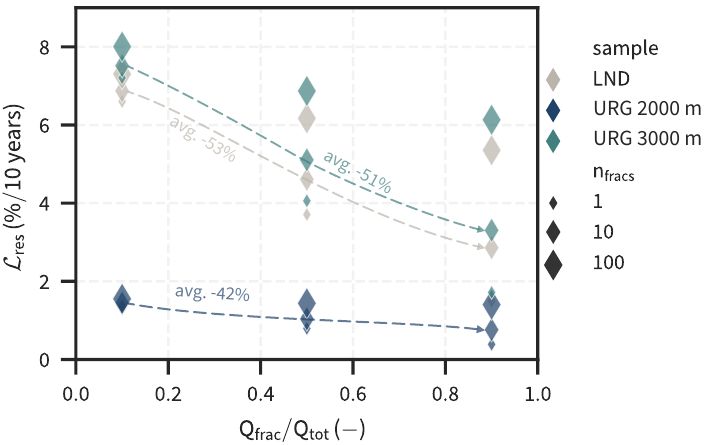
Figure 6. Effective reservoir permeability loss ( L res ) decreases as the flow rate ratio of the fracture layer ( Q frac / Q tot ) increases. Only the scenario with the base injection flow rate of 100 m 3 /h are shown after the final simulation time of ten years. The average losses for each input fluid sample are indicated as dashed